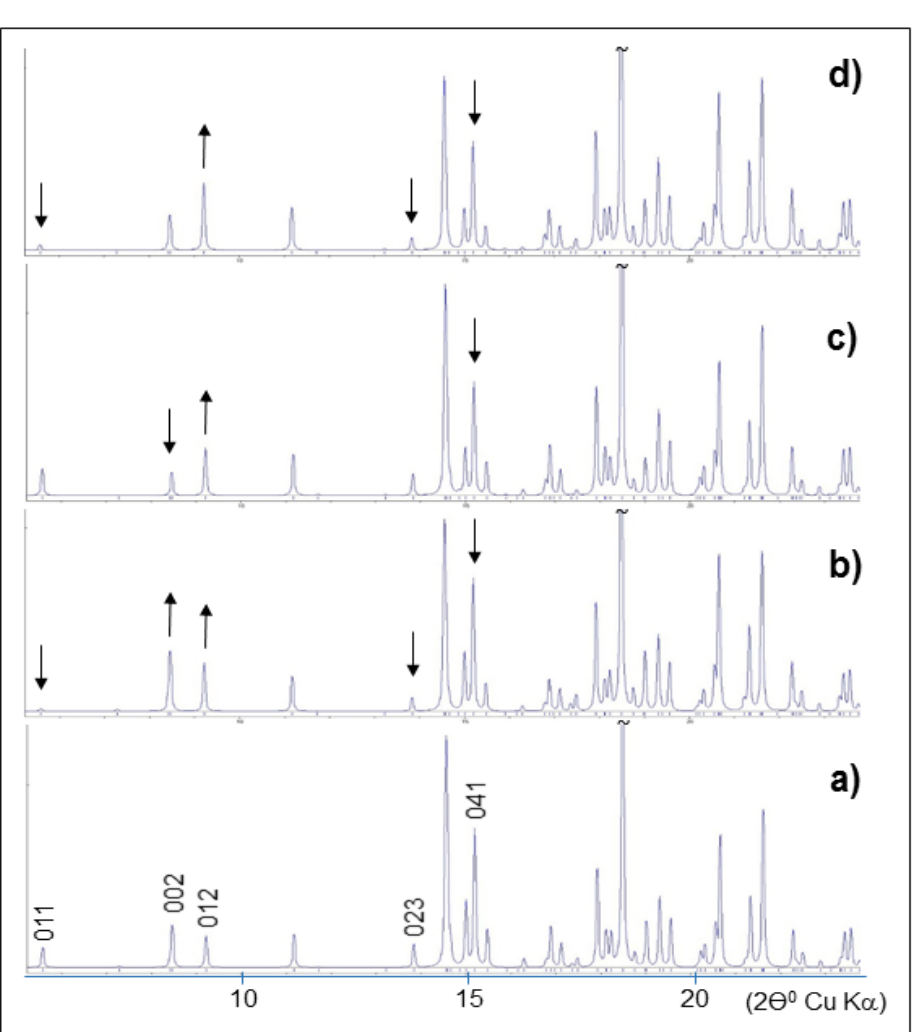
Figure 7. XRD patterns simulation obtained with PowderCell program: ( a ) original data of pickeringite, MgAl 2 (SO 4 ) 4 ·22H 2 O, with Al1 and Al2 sites totally occupied by aluminium [33]; ( b ) Al:Fe occupancy in Al1 site, 0.5:0.5; ( c ) Al:Fe in Al2 site, 0.5:0.5; ( d ) Al:Fe occupancy in both Al1 and Al2 sites, 0.5:0.5. The Miller indices are indicated for the lines that change the intensity, compared to the original data, with the variation indicated by arrows.